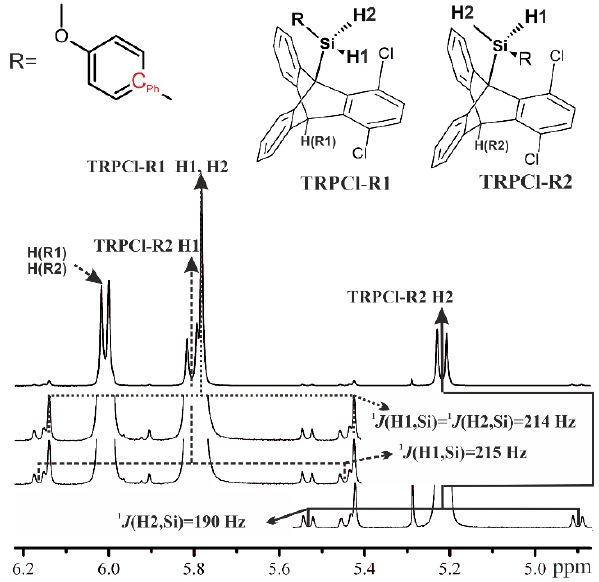
Figure 2. 1 H NMR spectra for chloroform- d solutions of TRPCl, which exists in the form of two rotamers, TRPCl-R1 and TRPCl-R2 [124]. Copyright Royal Society of